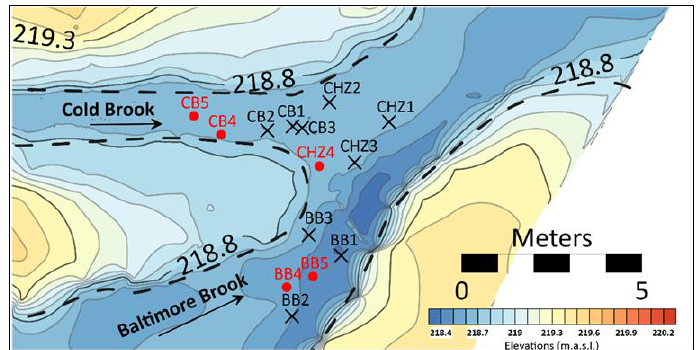
Figure 2. Riverbed monitoring for FS-BBCB2 showing hydraulic conductivity test location (black X), soil sample test locations (red circle).